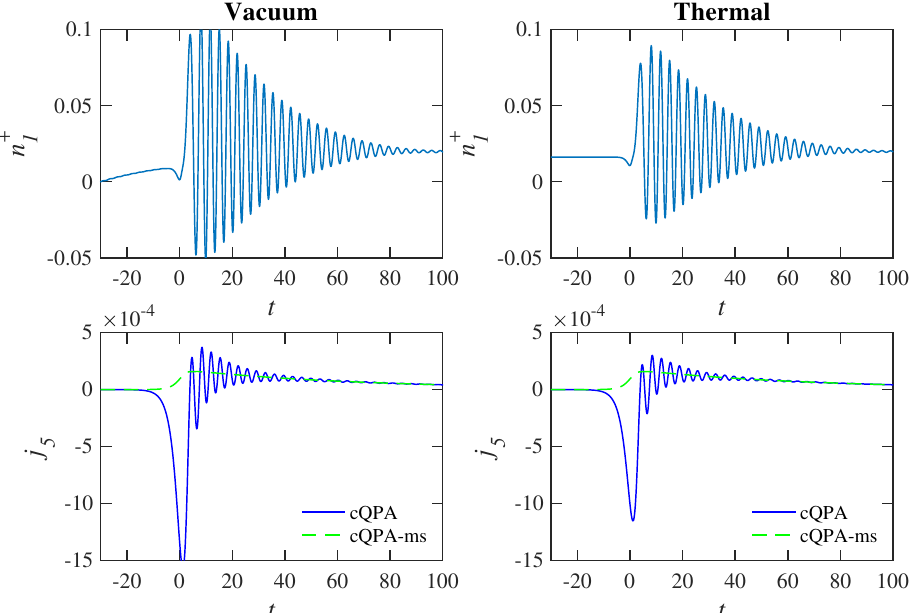
Figure 9. Shown is the integrated number density n + of positive helicity particles (the upper 1 panels) and the integrated axial charge density j 5 (the lower panels) in interacting cQPA. The left panels correspond to the vacuum initial condition and the right panels to the thermal initial condition with T = 1. We used the same set of mass parameters as in (cid:12)gure